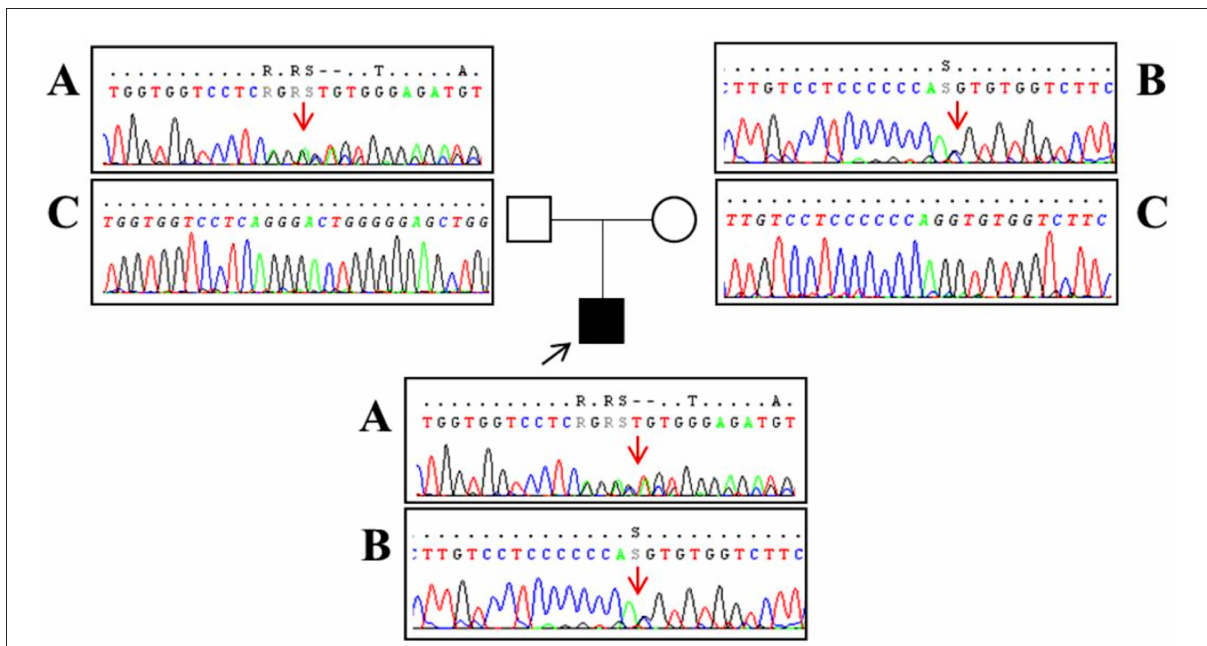
FIGURE1 Sanger sequencing analysis performed in our patient (black square) revealed a two-base deletion (c.558_559delAG) in exon 8 of the CLN3 gene [ (A) red arrow] and a splice-site mutation (c.461-1G > C) upstream exon 7 [ (B) red arrow]. Segregation analysis showed that the father (empty square) carries the c.558_559delAG mutation (A) and a wild-type allele (C) whereas the mother (empty circle) has the splice-site mutation (B) and a wild-type allele (C) . Base positions are referred to as the NM_000086 reference sequence (Ensembl genome browser, https://www. ensembl.org/).